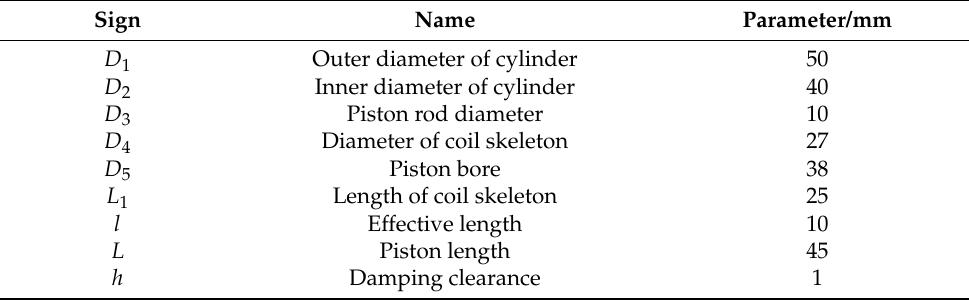
Figure 2. Structure dimension diagram of a piston. Table 1. The specific structure size of the magnetorheological damper.